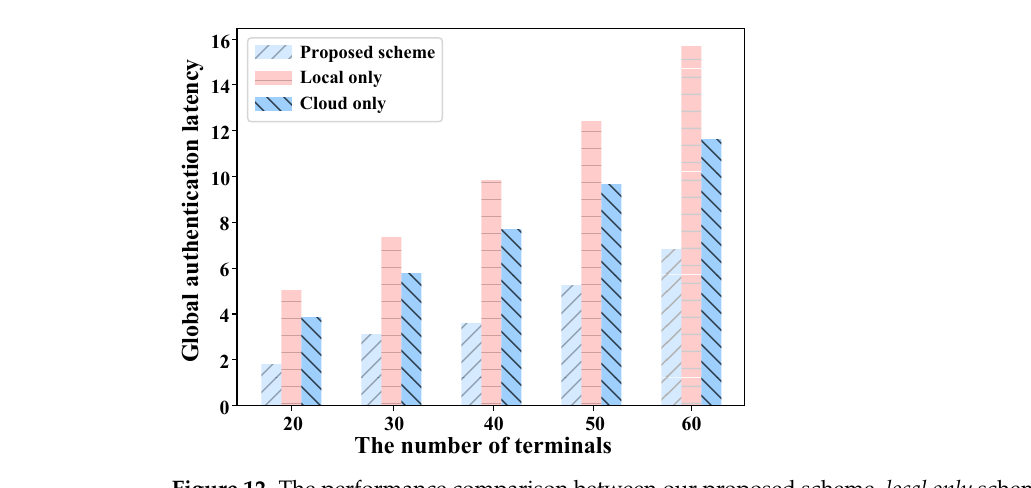
Figure 12. The performance comparison between our proposed scheme, local only scheme, and cloud only